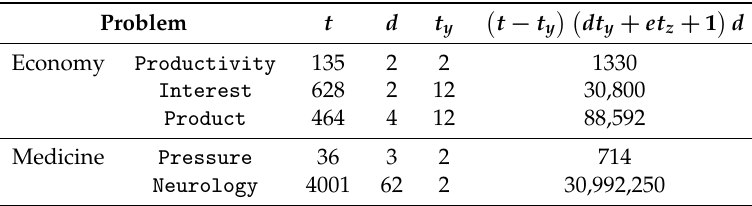
Table 6. Number of time instants, of internal variables and of time dependencies for the applications, and number of multiplications in the computation of the